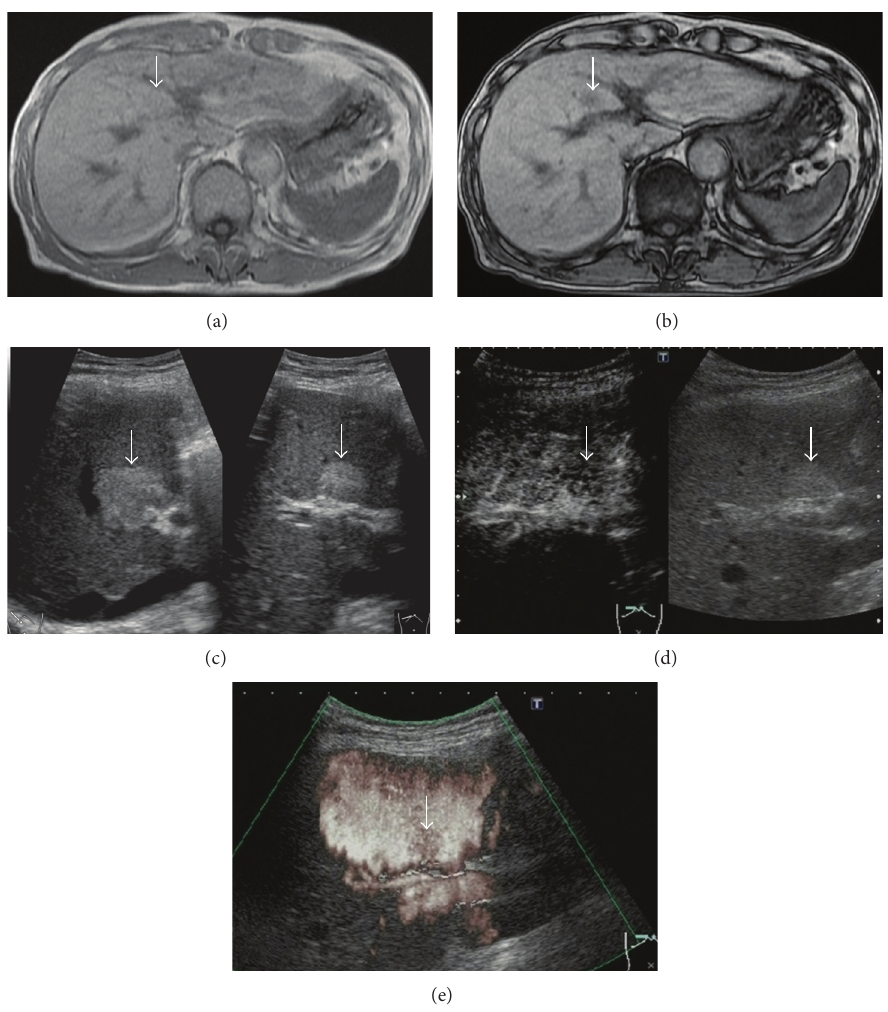
Figure 1: A 75-year-old male (case no. 24) with focal steatosis in the S4 (transverse portion). (a) In-phase T1-weighted magnetic resonance image (MRI) scan shows the isointense lesion (arrow) in the S4 (transverse portion). (b) The lesion is hypointense on an out of-phase T1-weighted MRI scan (arrow) and is diagnosed as focal steatosis. (c) Gray-scale ultrasonography (US) (right intercostal axis) shows a hyperechoic lesion (arrow). (d) Left: in the vascular phase (17 seconds) of contrast-enhanced ultrasonography (CEUS) (right subcostal axis), the lesion (arrow) is hypoenhancement compared with the surrounding liver. Right: gray-scale US (monitor mode) (arrow). (e) In the advanced dynamic flow (ADF) mode of the postvascular phase of CEUS (right intercostal axis), the lesion shows a hypoechoic area